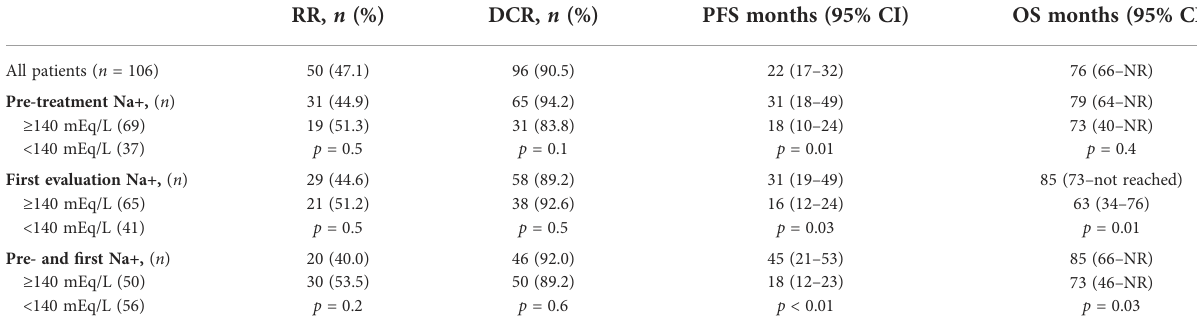
TABLE 5 Best response, PFS, and OS NA+ values in favorable risk